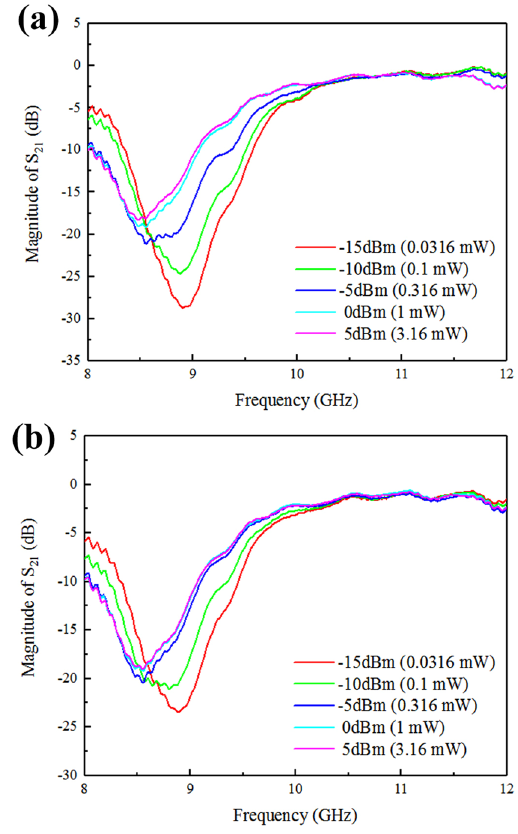
Figure 2. Measured transmission spectra under different incident microwave powers. ( a ) at room temperature (no bias temperature). ( b ) at a bias temperature of 50